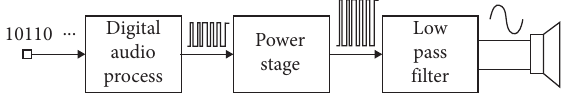
Figure 1: Class-D audio power amplifier block diagram.